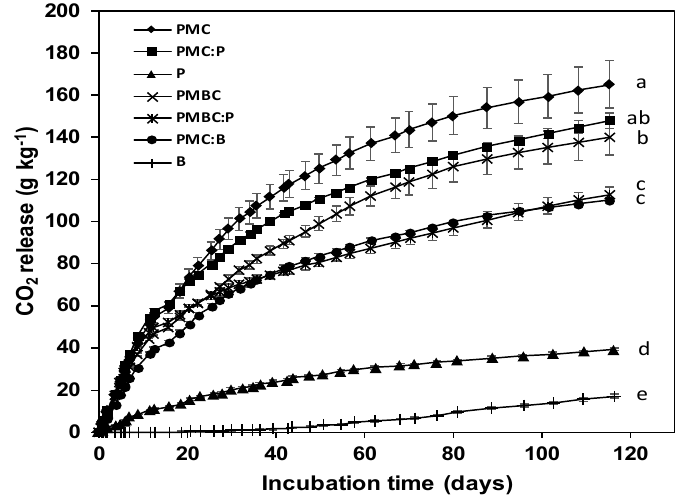
Figure 1. Cumulative CO 2 released from the materials (PMC = poultry manure composted without biochar; PMBC = poultry manure composted with biochar; P = peat; B = biochar) and their mixes (PMC:P, PMC:B and PMBC:P; 50%:50% by volume) during the incubation experiment. Three replicates (n = 3) were used for each substrate. Vertical bars in individual data indicate the standard error of the mean. Different letters indicate significant differences ( P < 0.05) between means for the accumulated CO 2 released at the end of the experiment according to one-way ANOVA and LSD test.